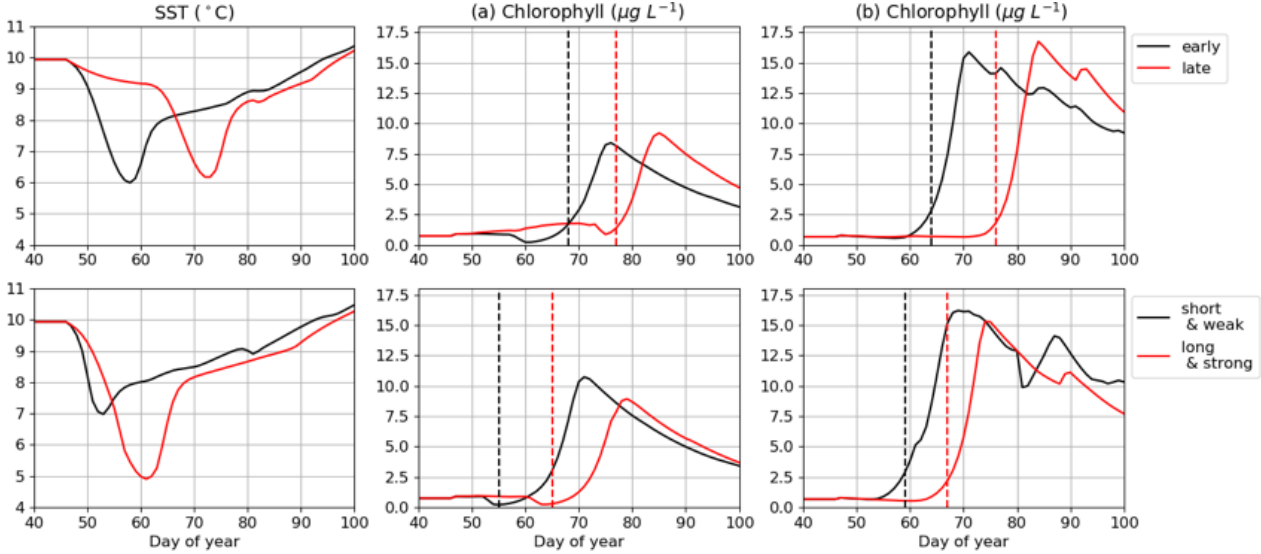
Figure 10. Impact of cold spells on the IPGP date simulated in (a) the Bay of Brest and (b) the Bay of Vilaine. Four conditions of cold spells are explored: early (mid-February), late (end of February), short (8d), and long (20d). The IPGP dates are represented by dashed